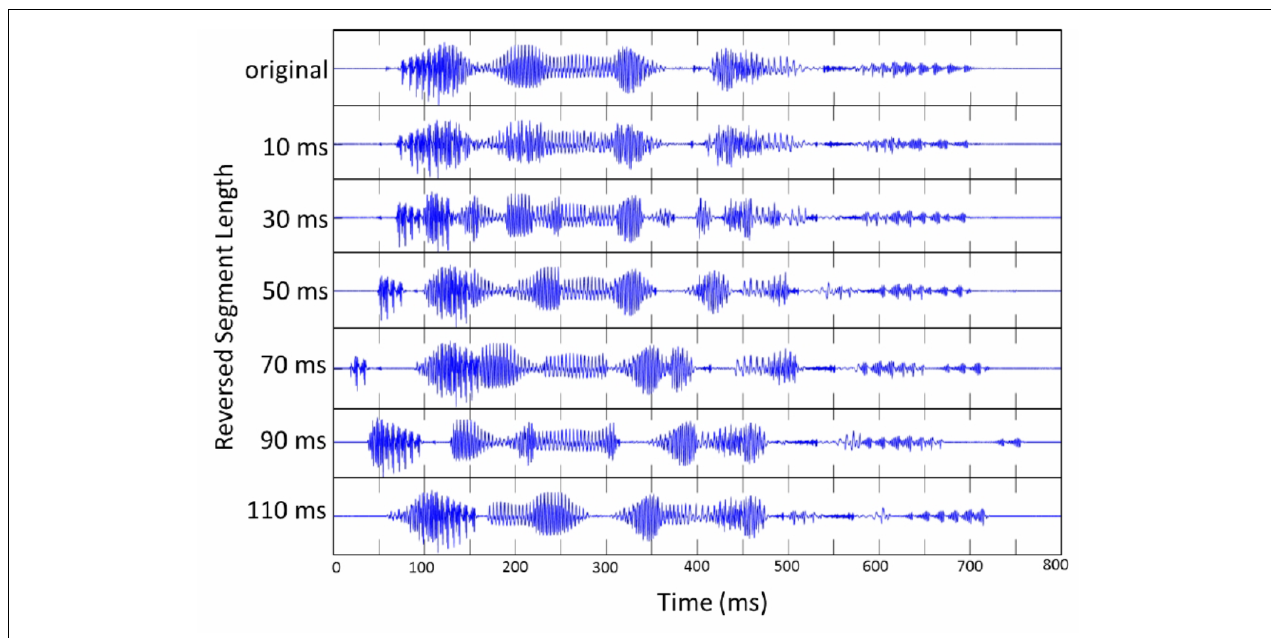
FIGURE 1 | The waveform of “I will look into it” (original) is shown at the top. The waveform of locally time-reversed speech is displayed below next to the corresponding reversed segment length: 10, 30, 50, 70, 90, and 110